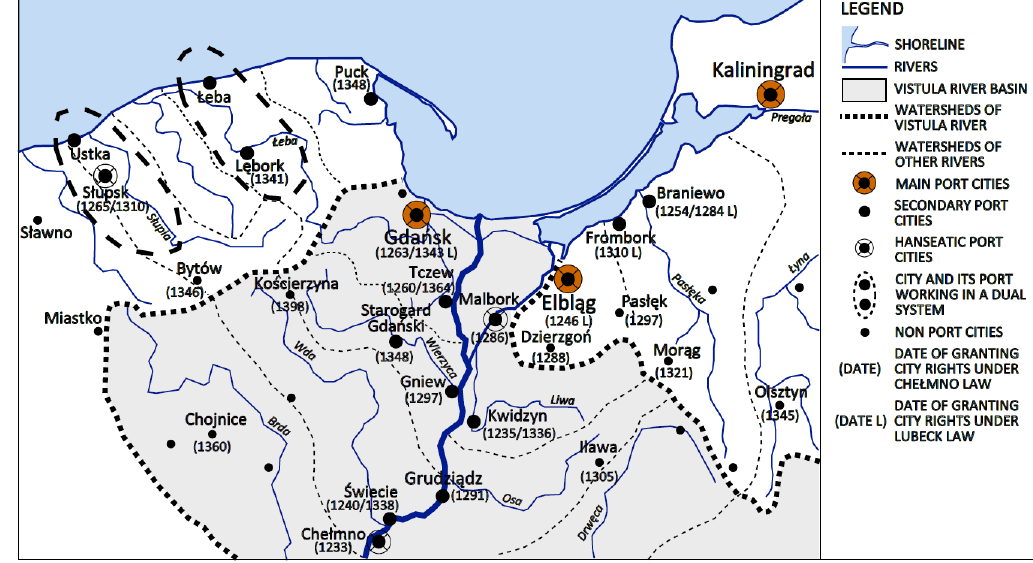
Figure 4. Gdańsk Bay port region geography in Hansa times (around the year 1400). The hinterland is defined by the acces‐ sibility of water transport. The lines of watersheds are shown